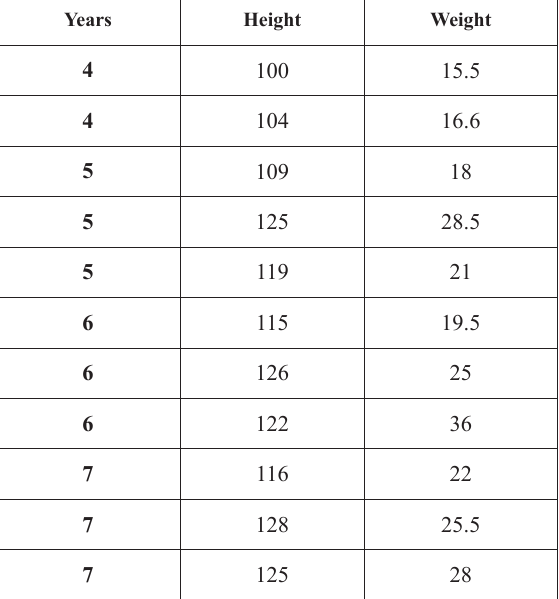
Table 1. Participants’ age, height and